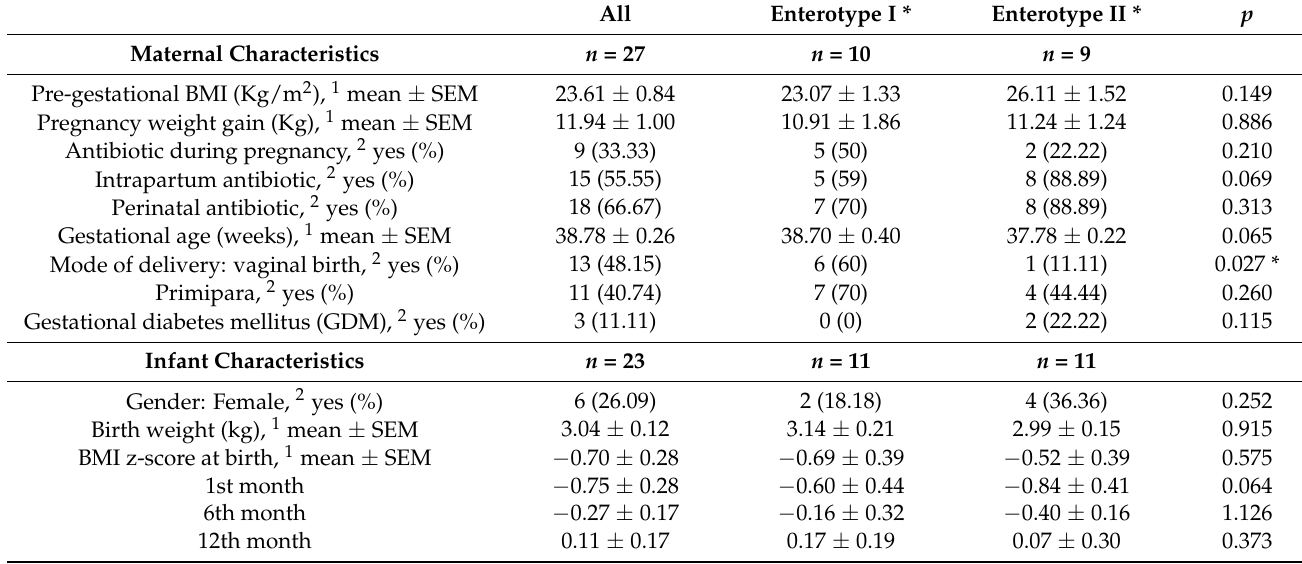
Table 1. Mother–infant birth cohort